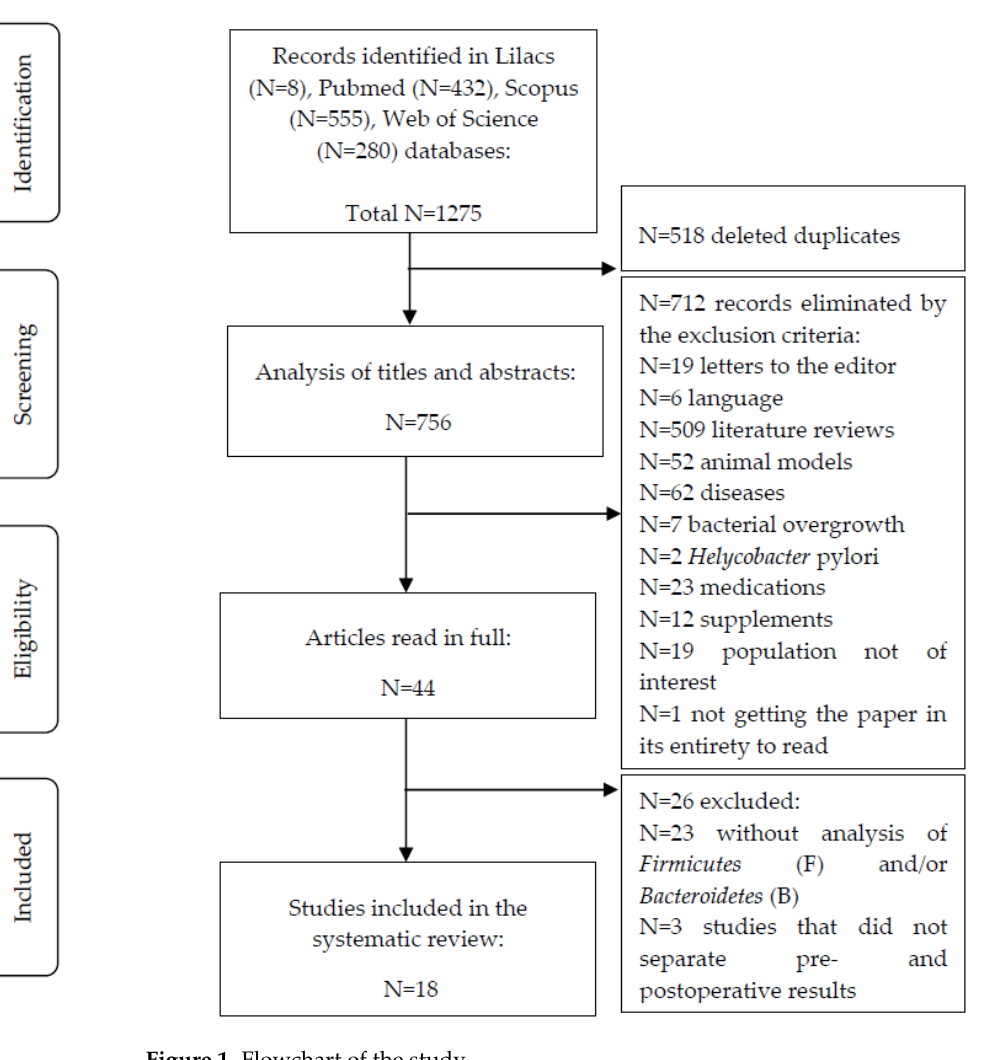
Figure 1. Flowchart of the study.